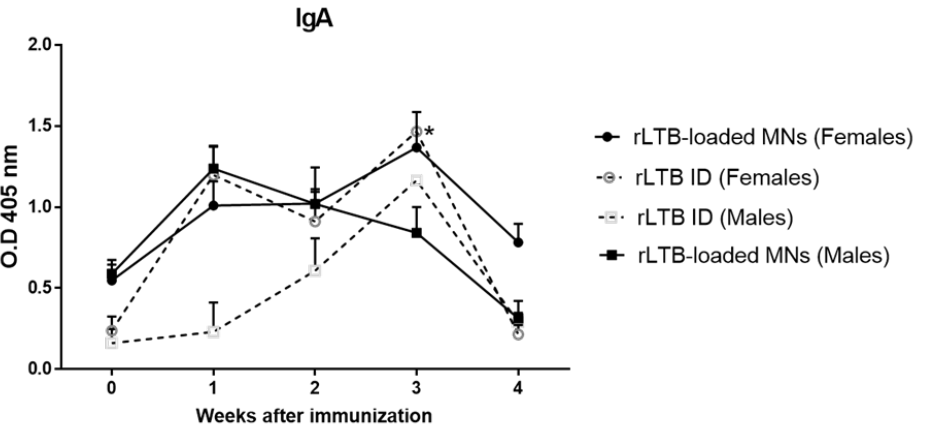
Figure 5. rLTB-specific IgA antibodies in immunized mice. BALB/c mice (females and males) ( n = 5) were immunized by intradermal (ID) or MN arrays with 5 µ g of recombinant of heat-labile enterotoxin B (rLTB) from Enterotoxigenic Escherichia coli (ETEC) H10407 (ATCC 35401). Specific IgA antibodies against rLTB in mice serum were determined by GM1-ELISA (* p < 0.05 vs. pre-immunization time). Error bars represent S.D.